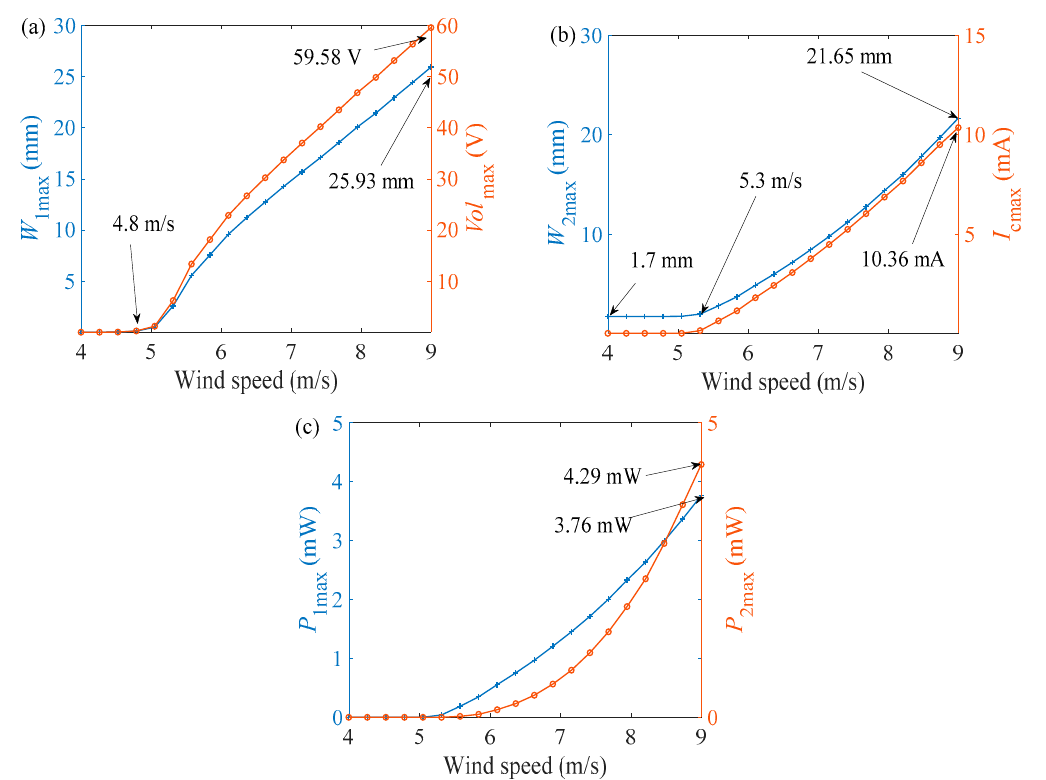
Figure 8. Curves of output parameters changing with wind speed under optimally matched loads ( a ) W 1max and Vol max ( b ) W 2max and I cmax ( c ) P 1max and P 2max.